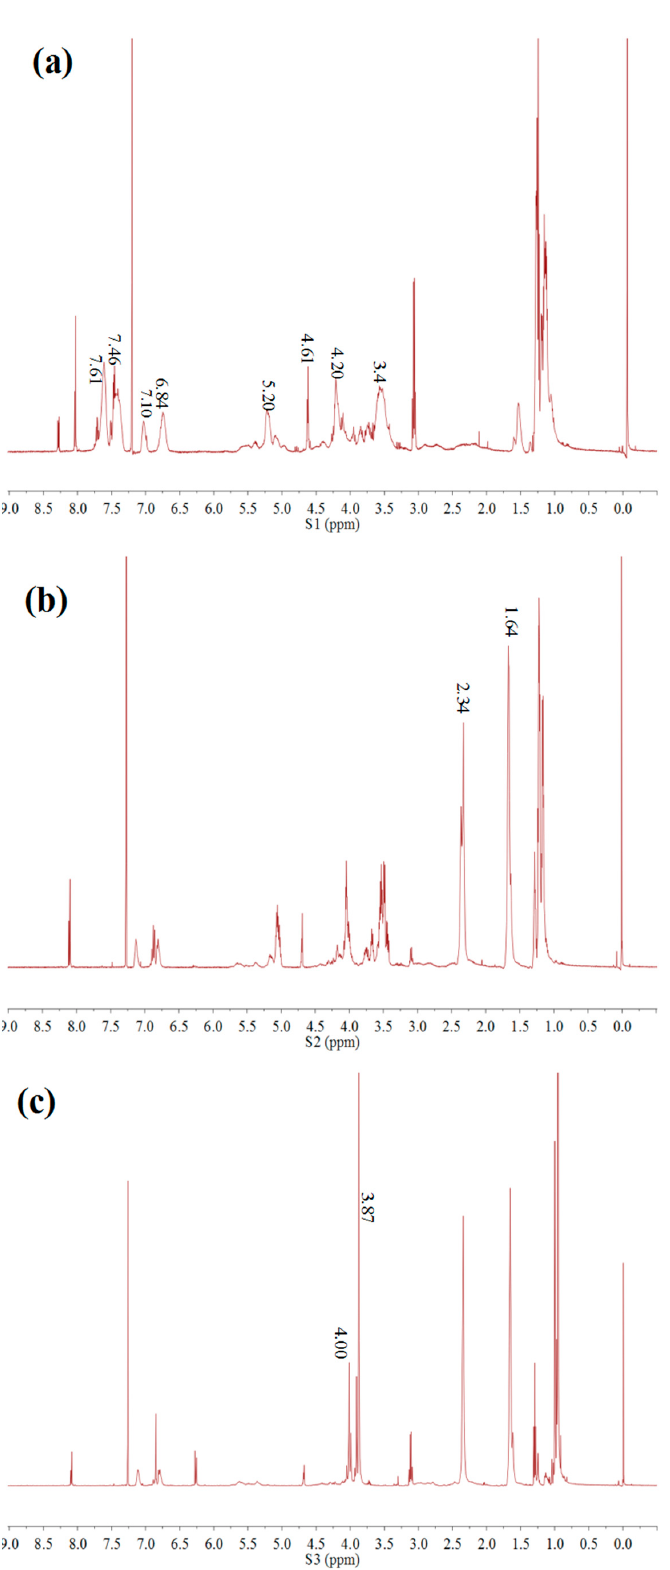
Figure 2. 1 H-NMR spectra of S1 ( a ), S2 ( b ) and S3 ( c ).